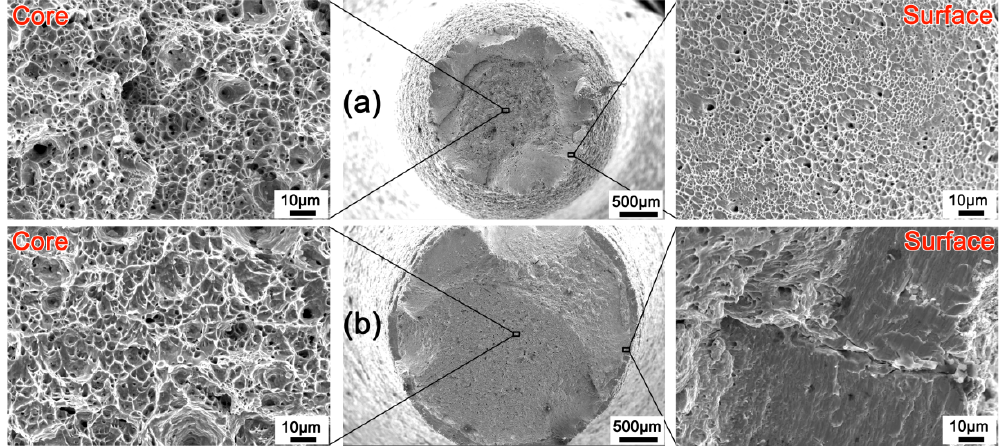
Figure 8. Fracture topography of different samples after tensile test: ( a ) L100; ( b ) H100.